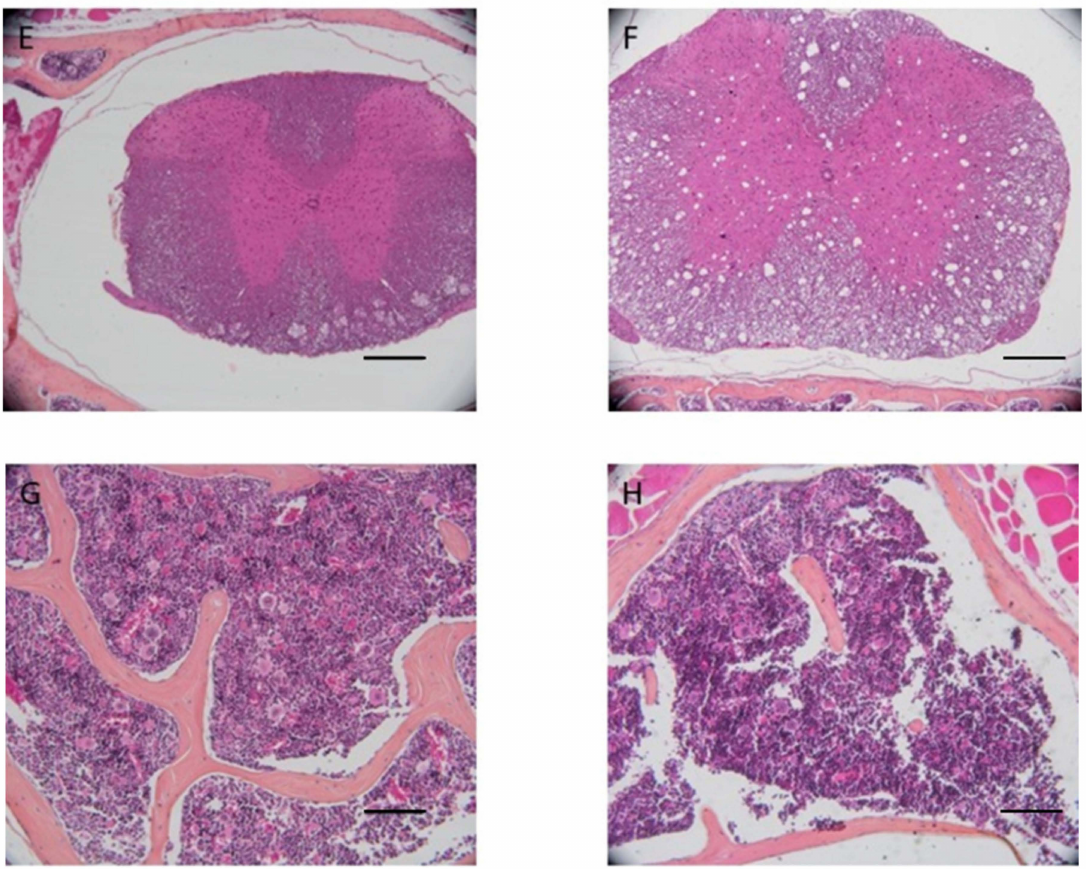
Figure 4. ( A , B ) Mouse head decalcified with EDTA-MW and Anna Morse’s solution, respectively, 40 × scale bar 400 µ m H&E staining. The formic acid solution causes some damage in the inner part of the cerebellum, identifiable as holes in the nervous tissue. ( C , D ) Mouse vertebra decalcified, respectively, with EDTA-MW and Anna Morse’s solution, 40 × scale bar 400 µ m H&E staining. A similar type of damage sustained by the cerebellum could be found in the spinal cord of the sample decalcified with Anna Morse’s solution. ( E , F ) Details taken at 100 × of mouse vertebra decalcified with EDTA-MW and Anna Morse’solution, 400 × scale bar 100 µ m H&E staining. ( G , H ) Detail of bone marrow, hematopoietic tissue is better preserved in the sample decalcified with EDTA-MA ( G ) than in the one decalcified with Anna Morse’s solution ( H ) 400 × scale bar 40 µ m H&E